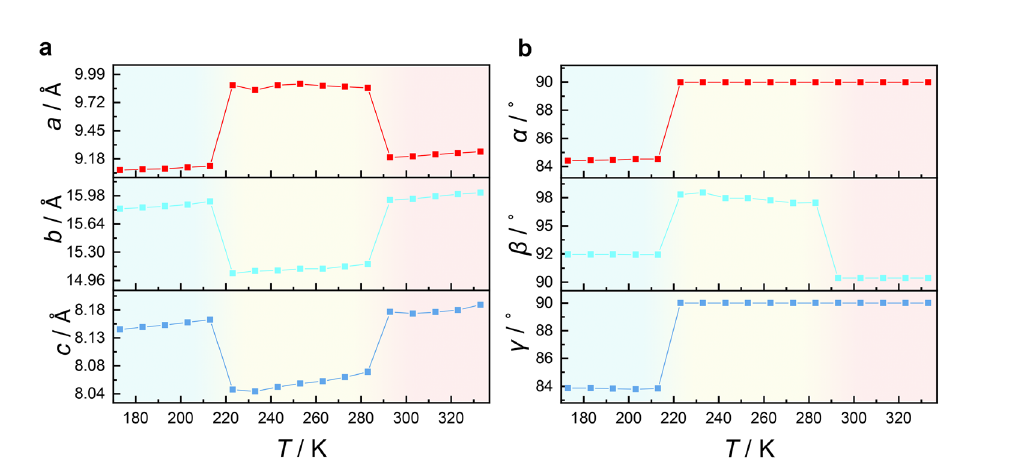
Fig.3|Temperature-dependentunit-cellparametersof1.a Normalizedunit-celllengthand b unit-cellangleof 1 .Thesharpchangesincellparameterscorrespondtothe phase transitions. Source data are provided as a Source Data fi